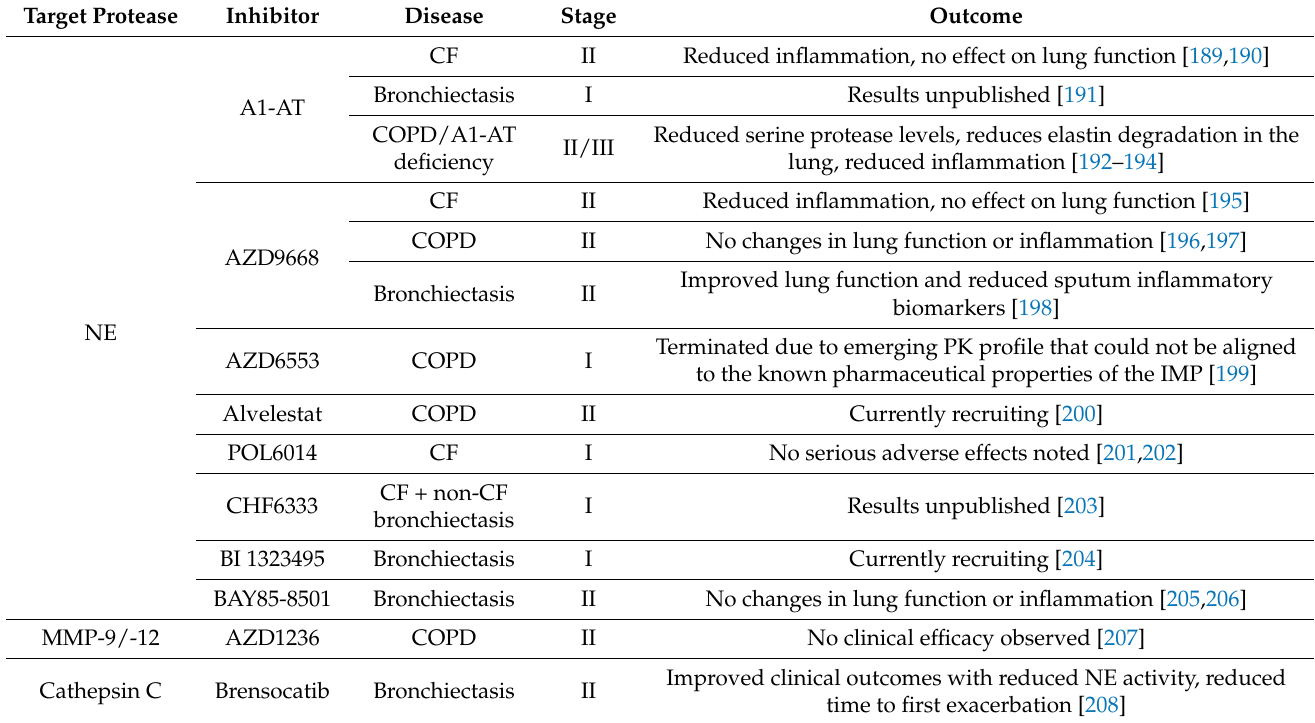
Table 1. Overview of clinical trials undertaken using protease inhibitors in patients with muco-obstructive lung diseases including CF, COPD, and